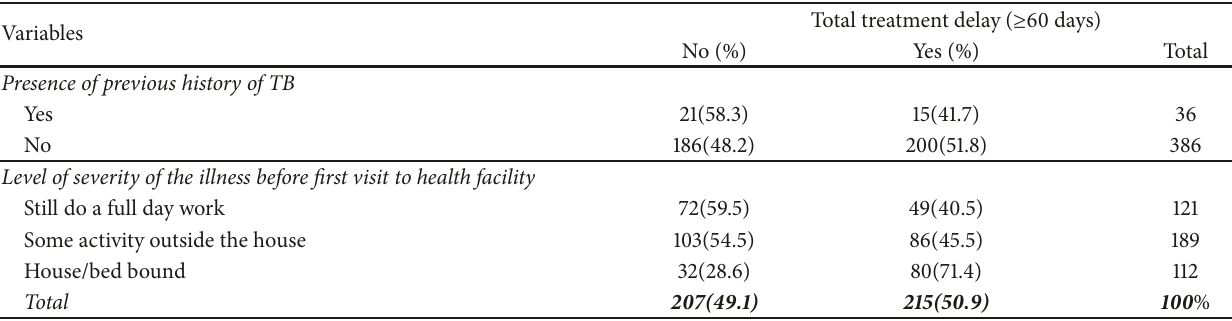
Table 6: Distribution of total treatment delay among clinical profiles of the study participants in selected health facilities of Gedeo Zone, southern Ethiopia, 2017/18.